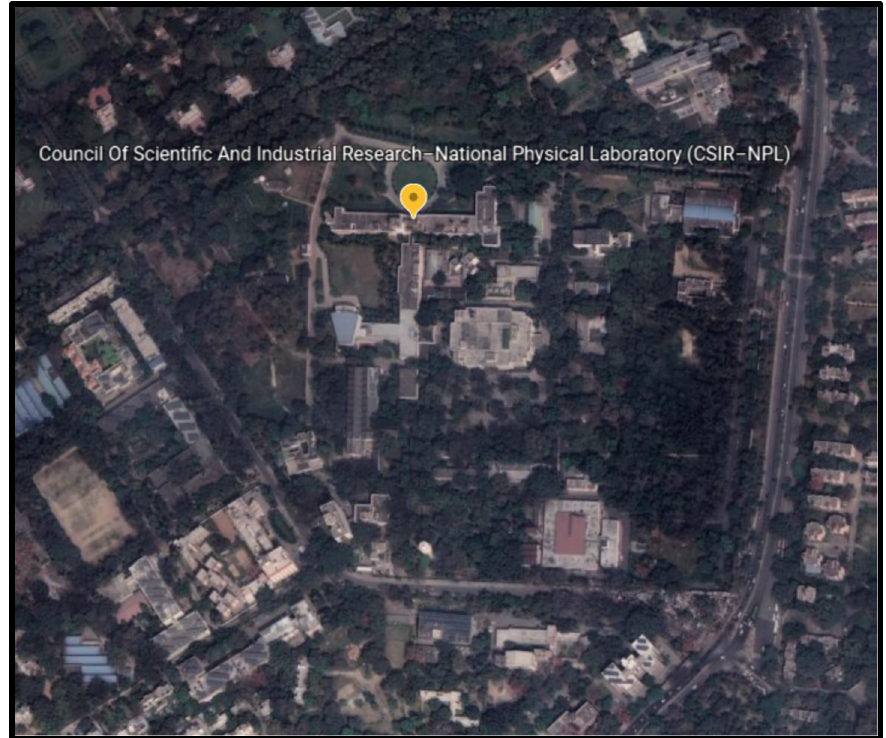
Figure 1. Sampling location CSIR-NPL at New Delhi, India [41]. Table 1. Details of sampling duration for PM 2.5 samples collected during Smog-2017. Sr. No.